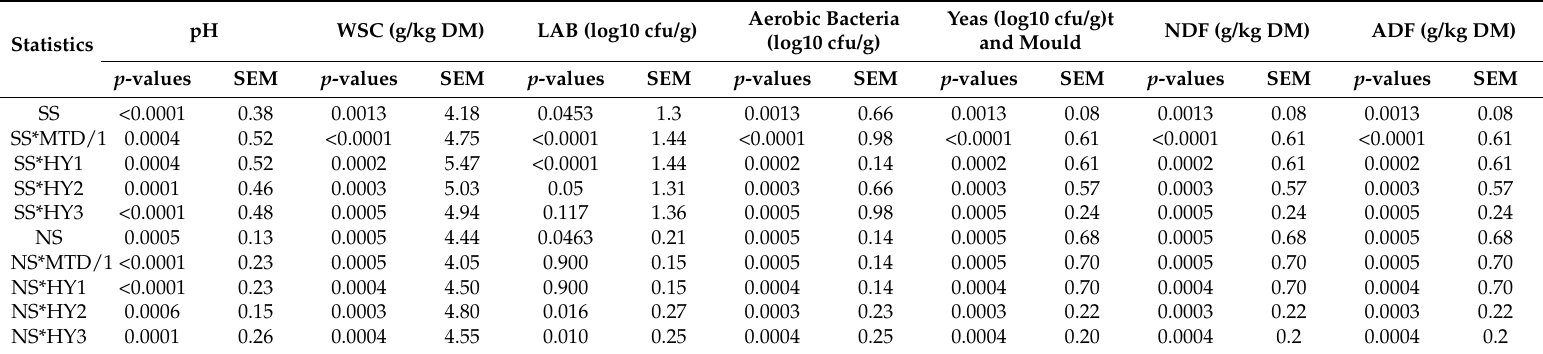
Table 6. Statistics analysis of pH, WSC and microbial population of sweet sorghums and Napiergrass on day 60 of incubation compared to fresh